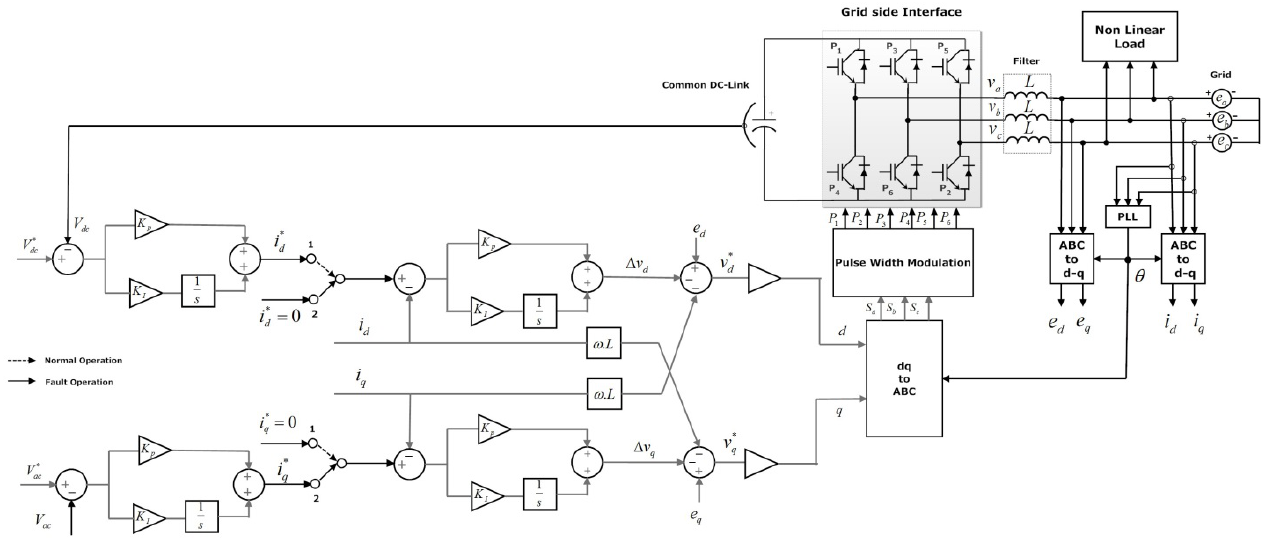
Figure 3. Control Strategy and operation of common Grid Side inverter in Parallel Connected WT Topology (i) under normal operation , (ii) under fault